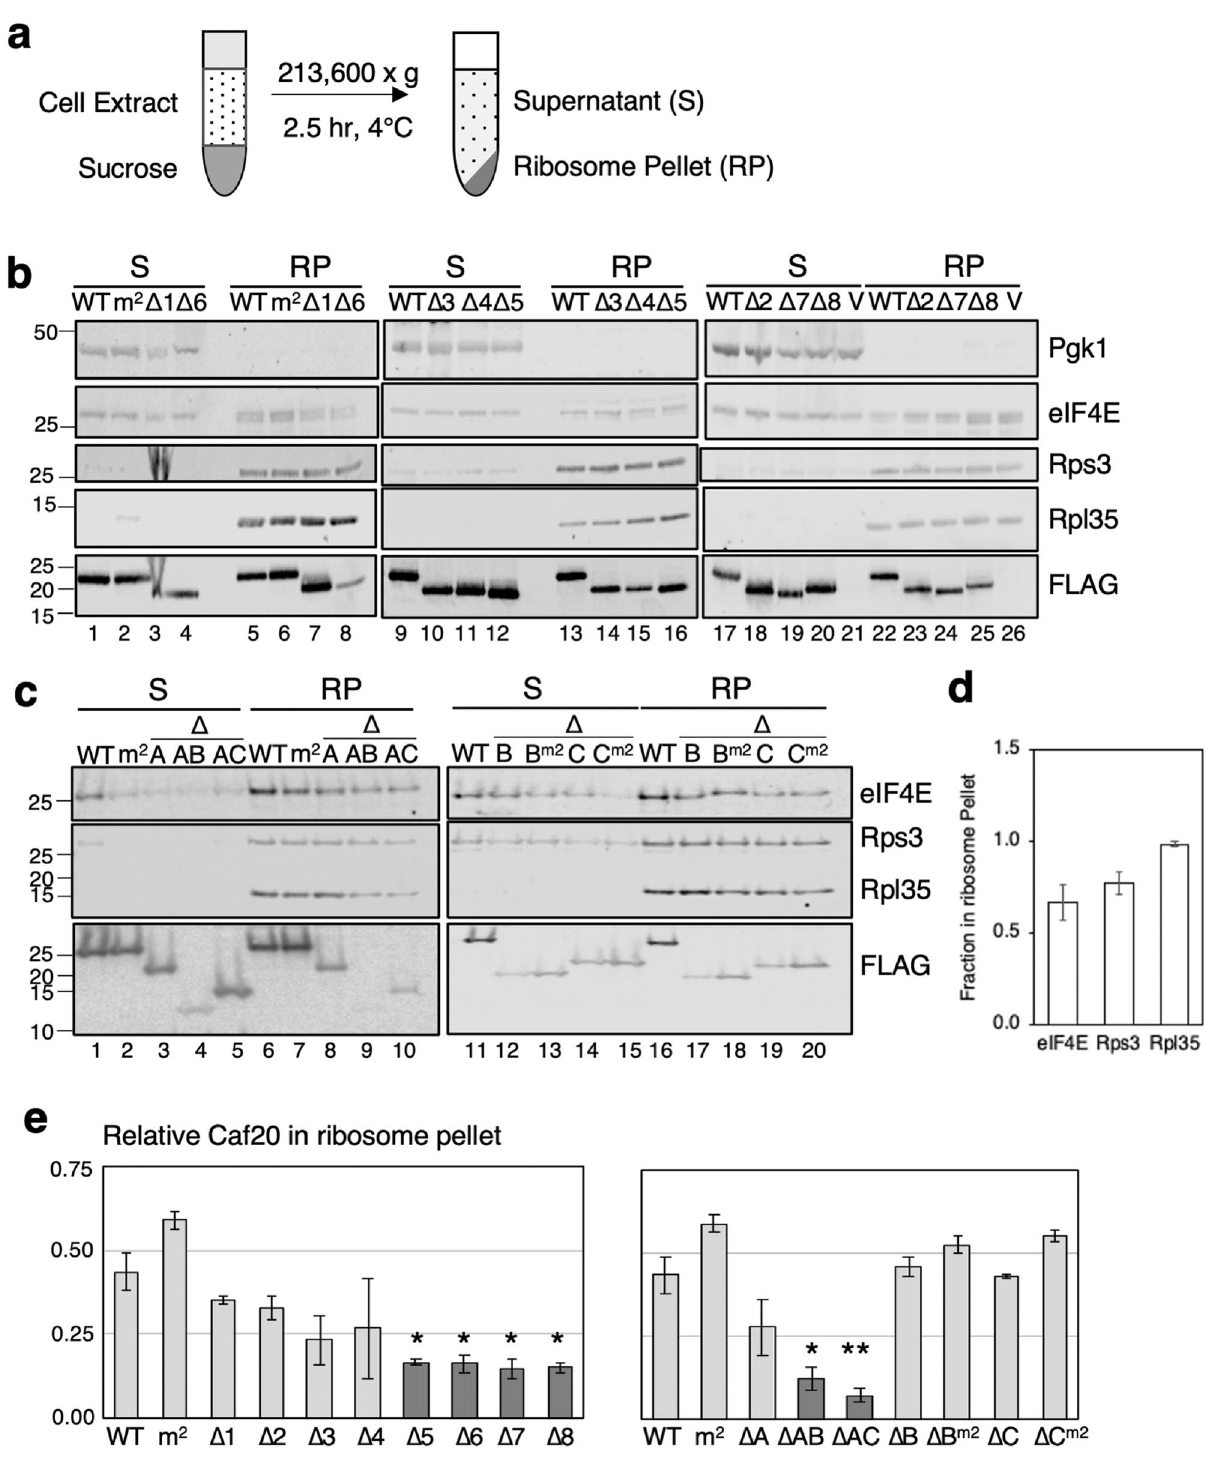
Figure 3. Caf20 mutants reduce ribosome binding. ( a ) Sucrose cushion and ultracentrifugation technique used to separate extract into supernatant and pellet fractions. ( b ) and ( c ) Western blots of supernatant (S) and ribosome pellet (RP) fractions of soluble proteins from cell lysates from strains bearing indicated Caf20 alleles. ( d ) and ( e ) Quantification of fraction of western blot signals in RP fractions (± SE). T-test (1-tailed) for significance * p < 0.05, ** p < 0.01 (n = 2–9) for samples compared to